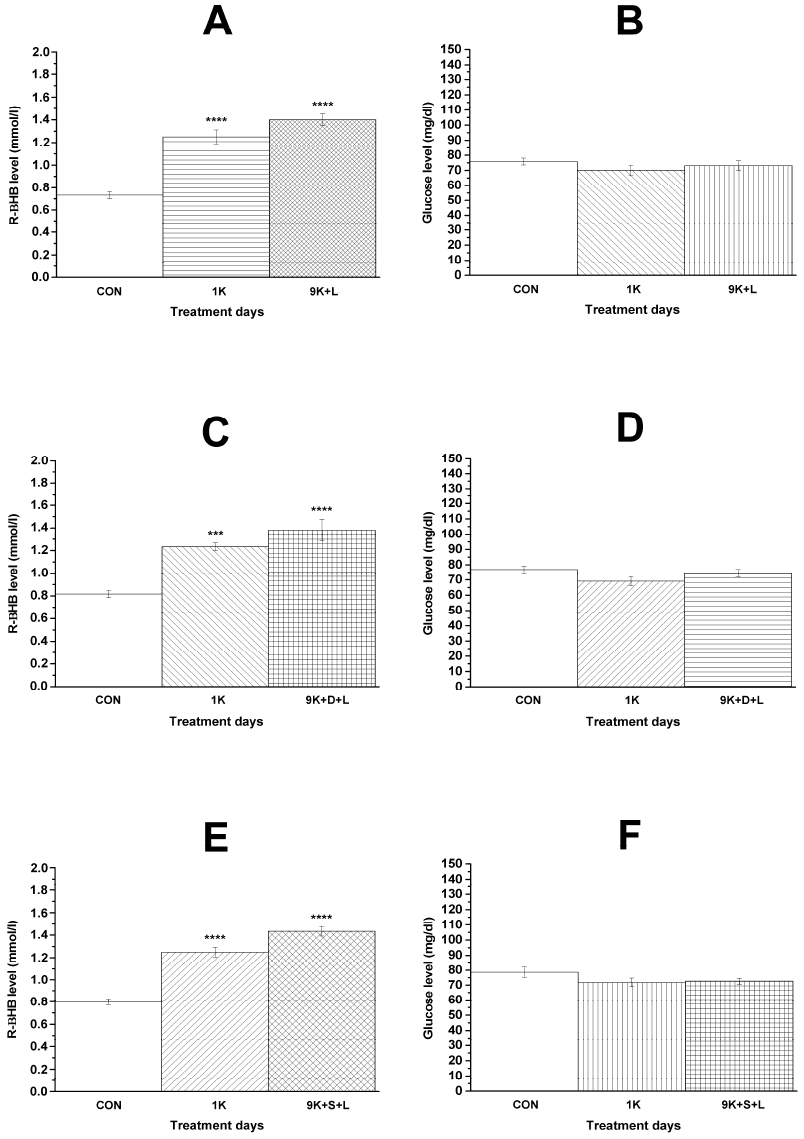
Figure 4. Changes in blood R- β HB and glucose levels on the first day of KEKS-supplemented food (10% ketone ester/KE, 10% ketone salt/KS and 1% saccharin in paste-like standard rodent chow) administration (1K; ( A – F )) and on the ninth day of KEKS food administration combined with i.p. LPS (50 µ g/kg) (9K + L; A , B ), with i.p. DPCPX (0.2 mg/kg) and LPS (9K + D + L; C , D ) and with i.p. SCH58261 (0.5 mg/kg) and LPS (9K + S + L; E and F ), compared to the control (CON; groups 4, 5, and 6, respectively). ***: p < 0.001 and ****: p < 0 .0001.